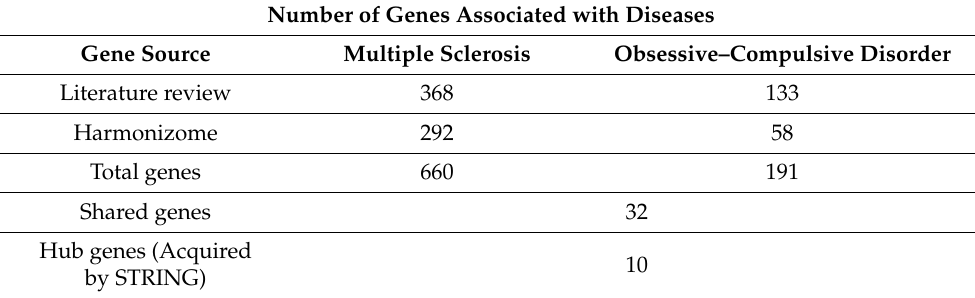
Table 1. The number of obtained genes from different search